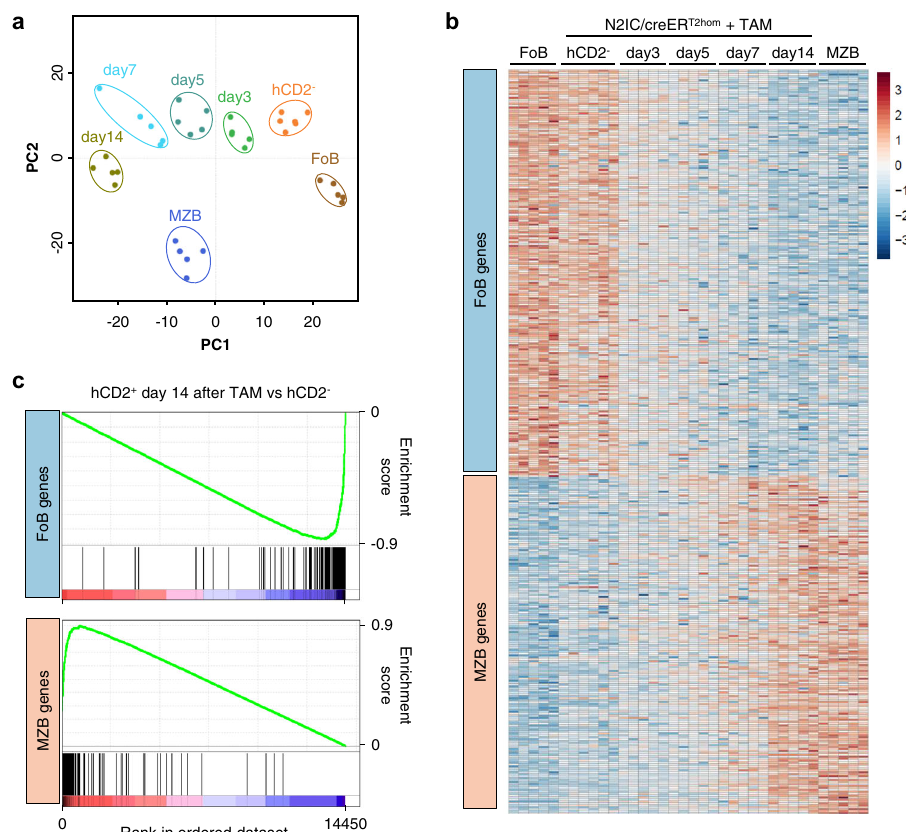
Fig. 4 Notch2IC induces a transcriptomic shift from FoB to MZB signature. Results of whole transcriptome RNA sequencing of 5-6 samples each of wild type FoB, MZB and hCD2 + and hCD2 − N2IC/creER T2hom cells 3, 5, 7, and 14 days after tamoxifen (TAM) induction. a Unbiased multidimensional scaling (MDS) plot of 10% most variable genes across all sequenced samples. b Heatmap of all sequenced samples using prede fi ned MZB signature gene sets ( “ FoB genes ” and “ MZB genes ” ) from control FoB and MZB cells as well as Notch2IC-expressing cells over time. Color scheme indicates log2-fold changes normalized across all samples. c Preranked GSEA analysis using the FoB and MZB signature gene sets. The ordered dataset displays 14450 genes, ranked for fold changes from upregulated (left) to downregulated (right) in hCD2 + versus hCD2 − cells 14 days after TAM treatment. Enrichment scores are − 0.87 for FoB gene set and 0.90 for MZB gene set (NOM p -values and FDR q -values < 10 − 3 for